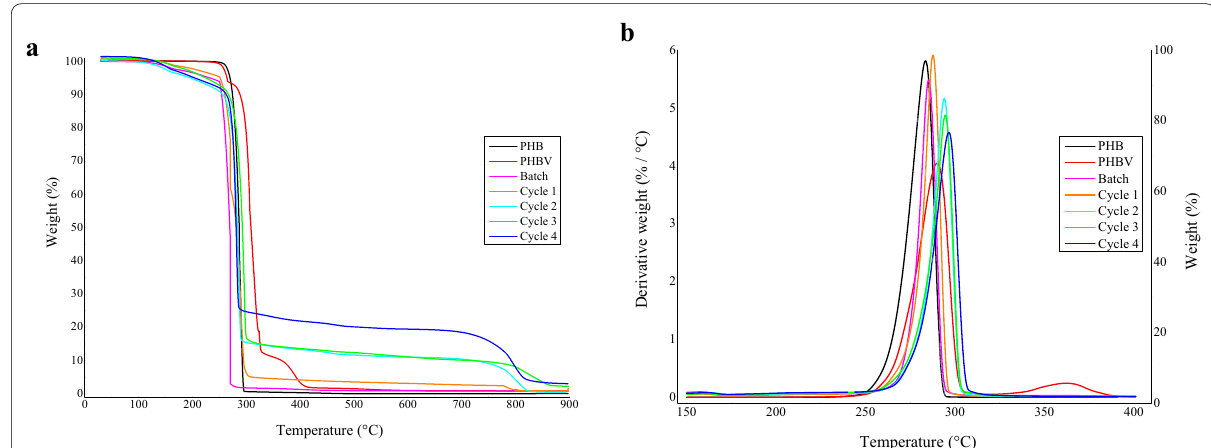
Fig. 5 TGA ( a ) and DTG ( b ) thermograms of commercial PHB and PHBV, and the PHAs obtained after each cycle of the cyclic fed-batch